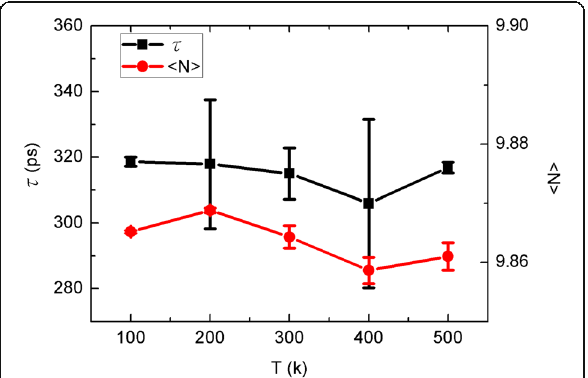
Fig. 3 The water translocation time τ and occupancy < N > as a function of the sheet temperature